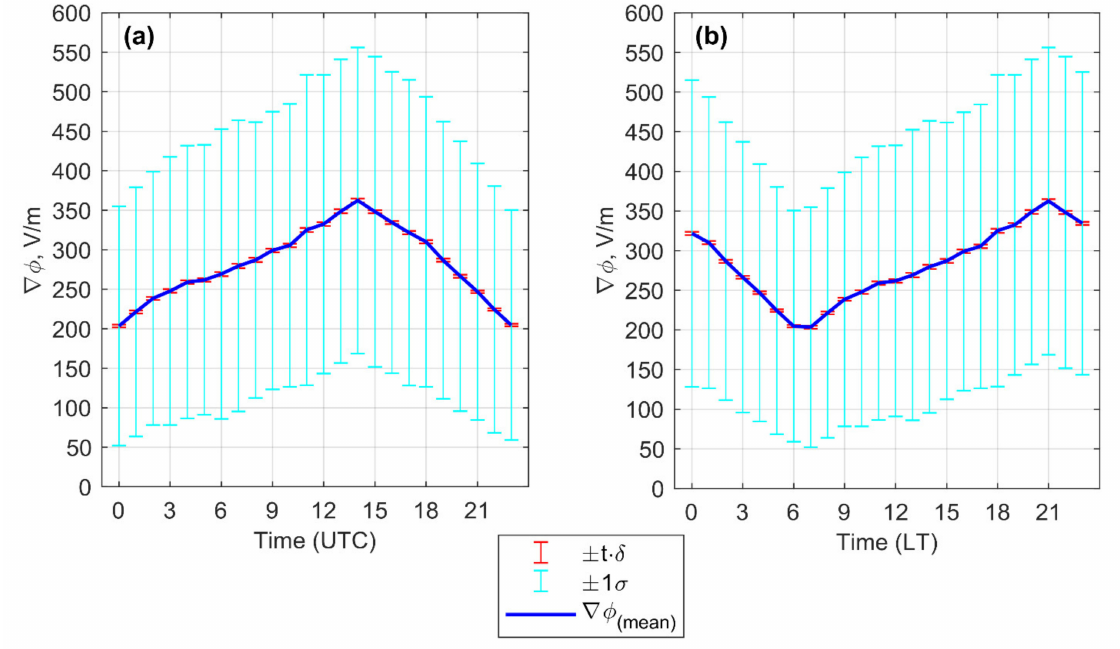
Figure 3. Hourly mean diurnal variation in the potential gradient under fair-weather conditions, calculated for 2006–2020. On the X -axis, UTC (Panel ( a )) and local time (LT) (Panel ( b )) are shown. In the figures, the width of the confidence interval ± t · δ is determined by the multiplication of the √ Student’s t -value ( t ) and the standard error of the mean ( δ = σ / N, where σ —standard deviation, N—sample length), and ± 1 σ —the range equal to one standard